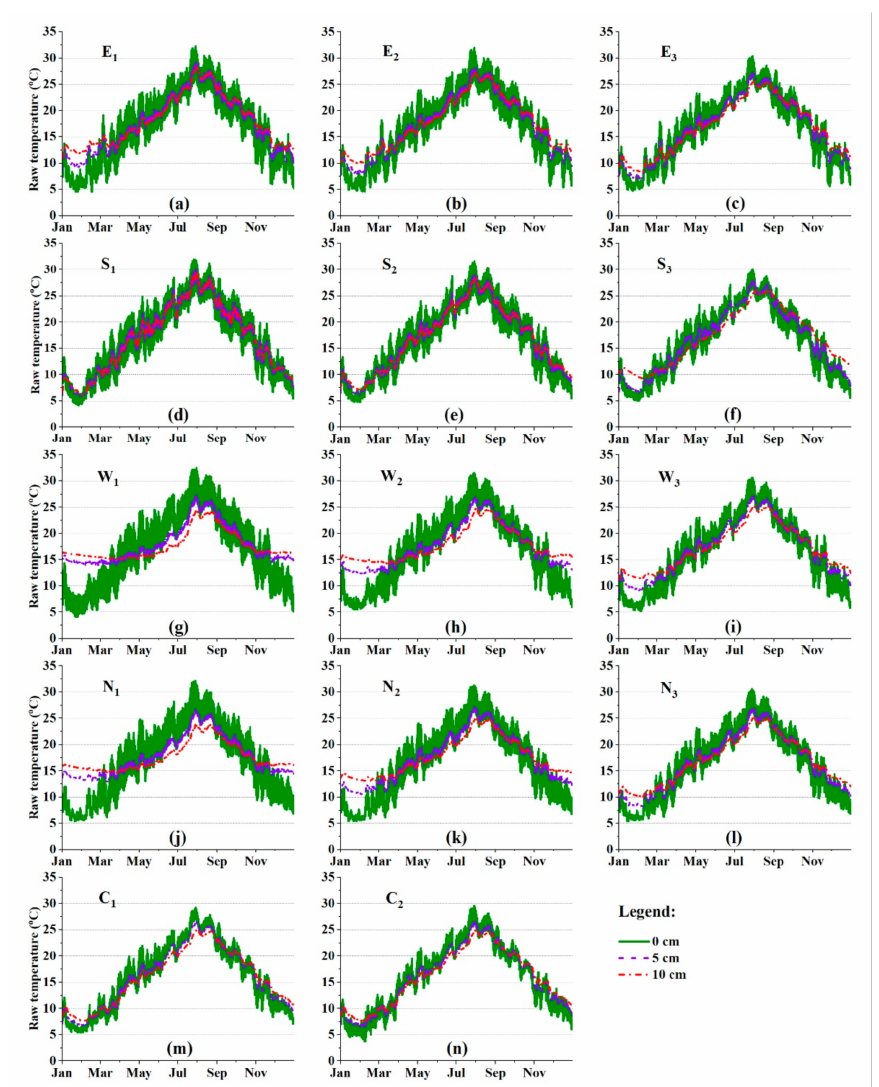
Figure 5. Temporal raw temperature at the sediment surface and depths of 5 and 10 cm of the eastern ( a – c ), southern ( d – f ), western ( g – i ), northern ( j – l ), and central sites ( m , n ) at Lake Taihu during 2016. Site locations see Figure